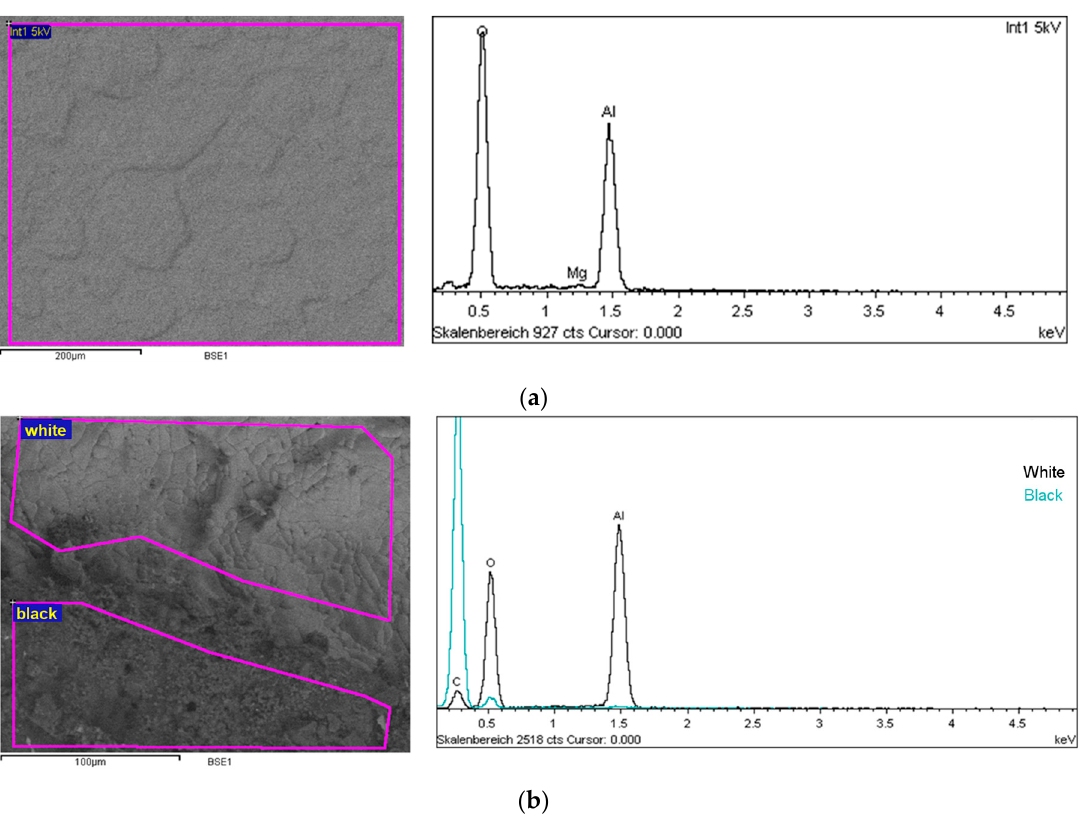
Figure 6. SEM images and Energy Dispersive X-ray Spectrometry (EDXS) spectra of the reacted surfaces: ( a ) Alumina reactor before reactions; ( b ) Alumina reactor after reaction. Table 4. Elemental composition (wt %) of the alumina surfaces obtained from EDXS analysis and referred to the surfaces in Figure 6.